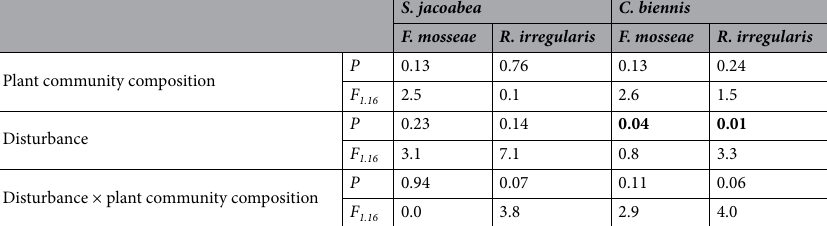
C. biennis F. mosseae R. irregularis F. mosseae R.